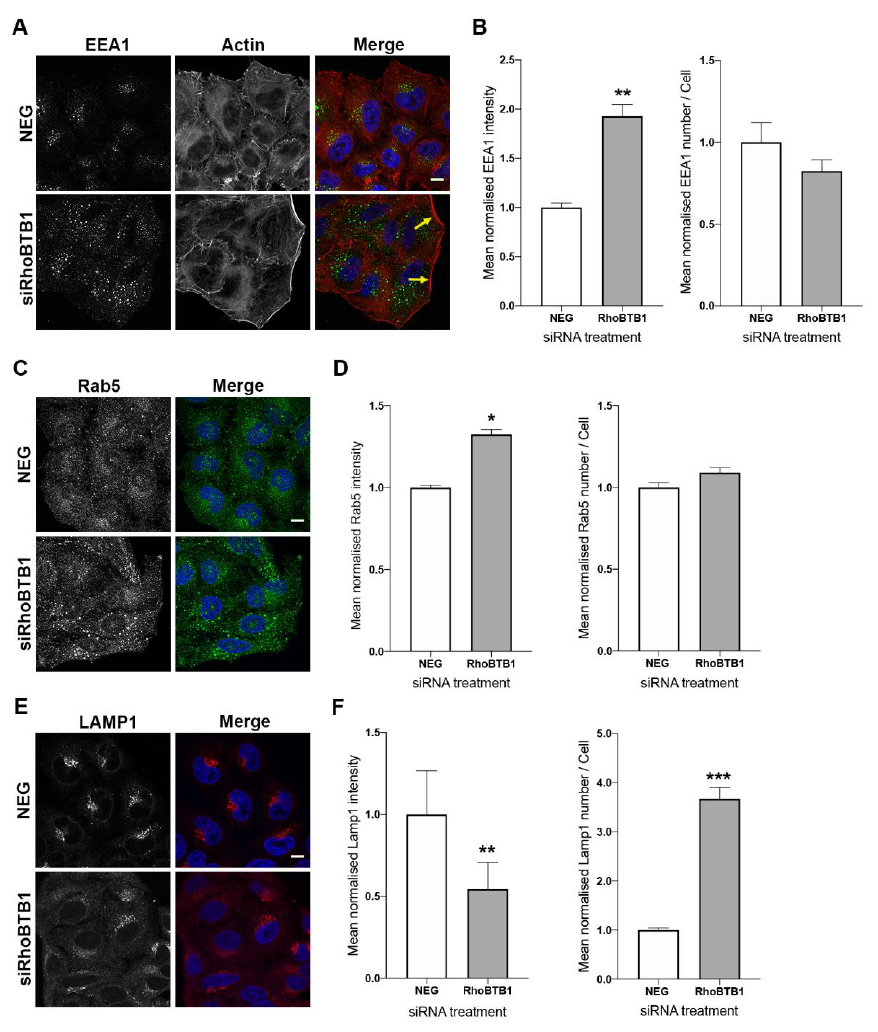
Figure 5. RhoBTB1 is important for architecture of the endosomal-lysosomal system. ( A ) Representative images of the e ff ect of RhoBTB1 depletion on early endosomes and actin cytoskeleton. HeLa Kyoto cells were treated with control (NEG) siRNAs or siRNAs against RhoBTB1 for 72 h. The cells were fixed and immunostained for markers of the early endosomes (EEA1) (green in merged image), stained for the actin cytoskeleton with phalloidin (red) and the nuclei with Hoechst 33342 (blue). Yellow arrows indicate intense staining of actin at the cell periphery. ( B ) Graphs showing the normalised mean intensity of EEA1 and the normalised mean number of EEA1 structures per cell upon siRNA treatment as indicated. Results are presented as mean ± s.e.m. of three independent experiments, with at least 64 cells analysed in total. ** p < 0.01 compared with NEG control cells. ( C ) Representative images of the effect of RhoBTB1 depletion on Rab5. HeLa Kyoto cells were treated with control (NEG) siRNAs or siRNAs against RhoBTB1 for 72 h. The cells were fixed and immunostained for Rab5. ( D ) Graphs showing the normalised mean intensity of Rab5 and the normalised mean number of Rab5 structures per cell upon siRNA treatment as indicated. Results are presented as mean ± s.e.m. of three independent experiments, with at least 64 cells analysed in total. * p < 0.05 compared with NEG control cells. ( E ) Representative images of the effect of RhoBTB1 depletion on LAMP1. HeLa Kyoto cells were treated with control (NEG) siRNAs or siRNAs against RhoBTB1 for 72 h. The cells were fixed and immunostained for LAMP1. Bars represent 10 μm. ( F ) Graphs showing the normalised mean intensity of LAMP1 and the normalised mean number of LAMP1 structures per cell upon siRNA treatment as indicated. Results are presented as mean ± s.e.m. of three independent experiments, with at least 64 cells analysed in total. *** p < 0.001 and ** p < 0.01 compared with NEG control